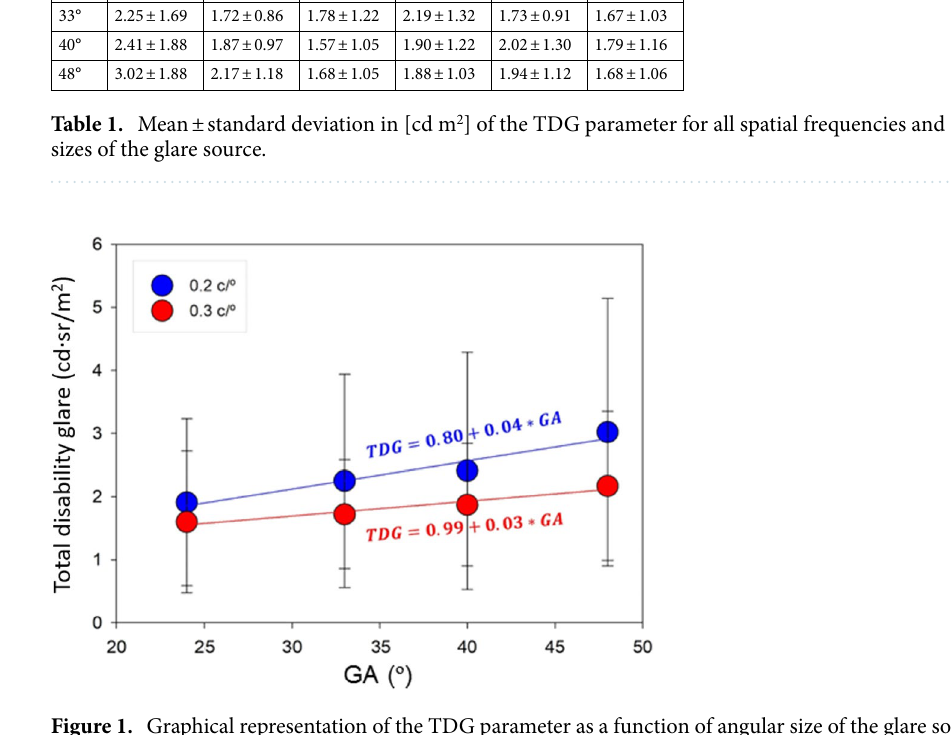
Figure 1. Graphical representation of the TDG parameter as a function of angular size of the glare source (GA) and linear regression for spatial stimulus frequencies of 0.2 ( R 2 = 0.943, p = 0.029 ) and 0.3 c/° ( R 2 = 0.942, p = 0.029